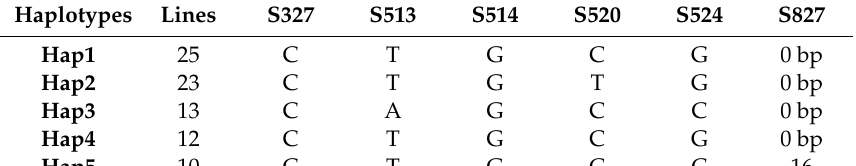
Table 4. Division of five haplotypes and corresponding base changes in ZmNAC9 gene. Haplotypes